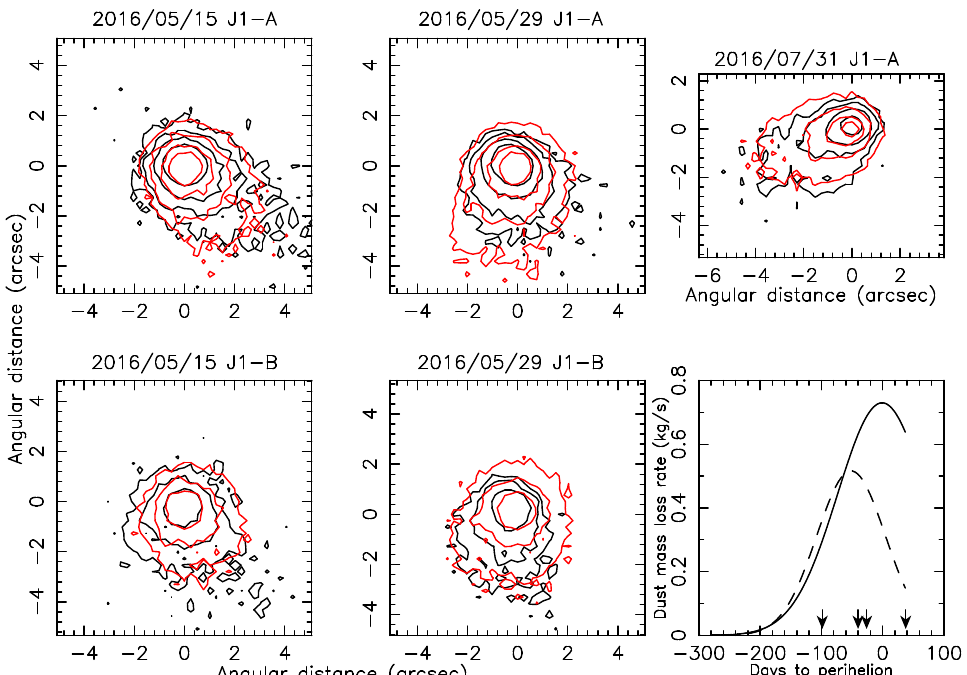
Figure 9. Measured isophotes (black contours) and best-fit model isophotes (red contours) for different dates for the two components J1-A and J1-B of asteroid P/2016 J1. The lowermost right panel displays the best-fit dust loss rate as a function of time to the perihelion for components J1-A (solid line) and J1-B (dashed line). Arrows indicate the different observation dates of the images. Adapted from